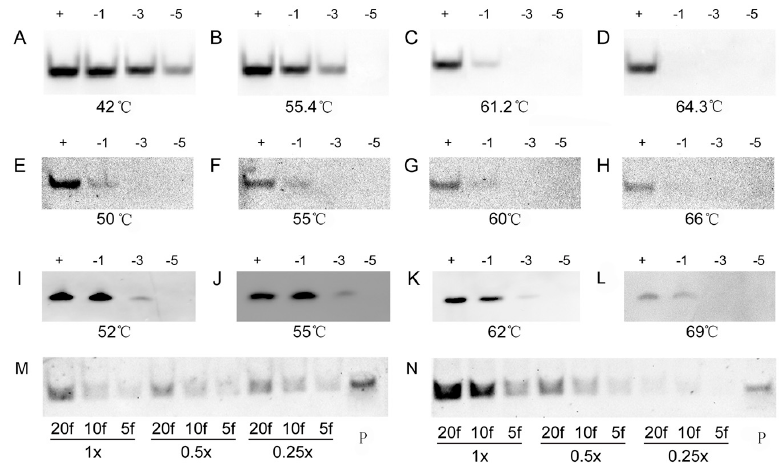
Figure 3. Specificity of LHSPD at different temperatures. ( A – D ) Hybridizations of 0.1 pmol ( DIG ) -miD156rk with 1 pmol miD156s at different temperatures by LHSPD; ( E – H ) Hybridizations of 0.1 pmol ( Biotin ) -miD156rk with 1 pmol miD156s at different temperatures by LHSPD; ( I – L ) Hybridizations of 0.1 pmol ( Biotin ) -miD156rk with 1 pmol miD156s at different temperatures by traditional Northern hybridization. miD156 marked “+”, miD156 with one-base mismatch marked “ − 1”, miD156 with three-base mismatch marked “ − 3” and miD156 with five-base mismatch marked “ − 5”; ( M ) Hybridization performed in 0.25×, 0.5× and 1× Exonuclease I reaction buffer (New England Biolabs, Inc., Beijing, China) with 0.1 pmol ( Biotin ) -miD156rk ; ( N ) Hybridization performed in 0.25×, 0.5× and 1× PNE buffer with 0.1 pmol ( Biotin ) -miD156rk ; 20f represents 20 fmol of miD156 ; 10f represents 10 fmol of miD156 ; 5f represents 5 fmol of miD156 ; P represents control containing 1 pmol of ( Biotin ) -miD156rk .